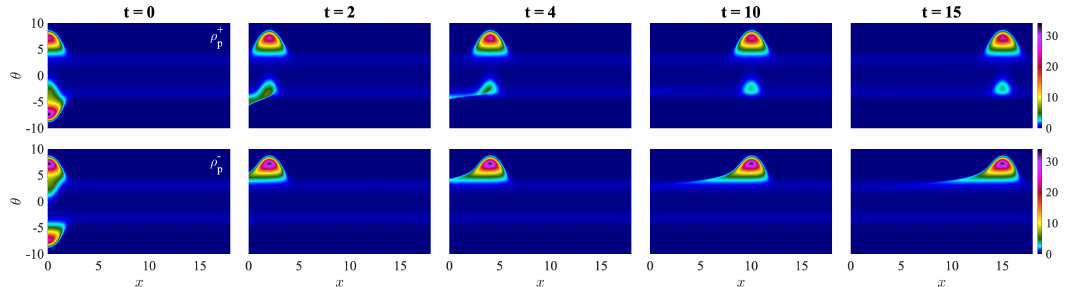
p x , t , θ q for x ě 0 in the pres- Figure 2: Snapshots of the spectral densities ρ ˘ p “ e 3 , σ “ 10 and 2 T “ e 7 . Recall that ence of a bath at temperature 2 T a m ρ ` p x , t , θ q “ ρ ´ p´ x , t , ´ θ q . Whilst the interacting and free fermion peaks p p